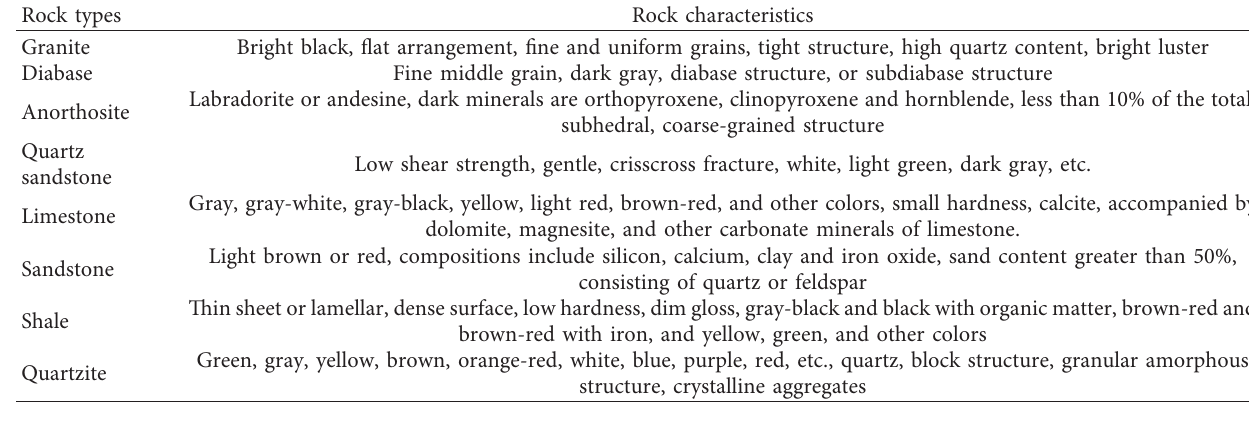
Table 2: Analysis of rock types and characteristics.